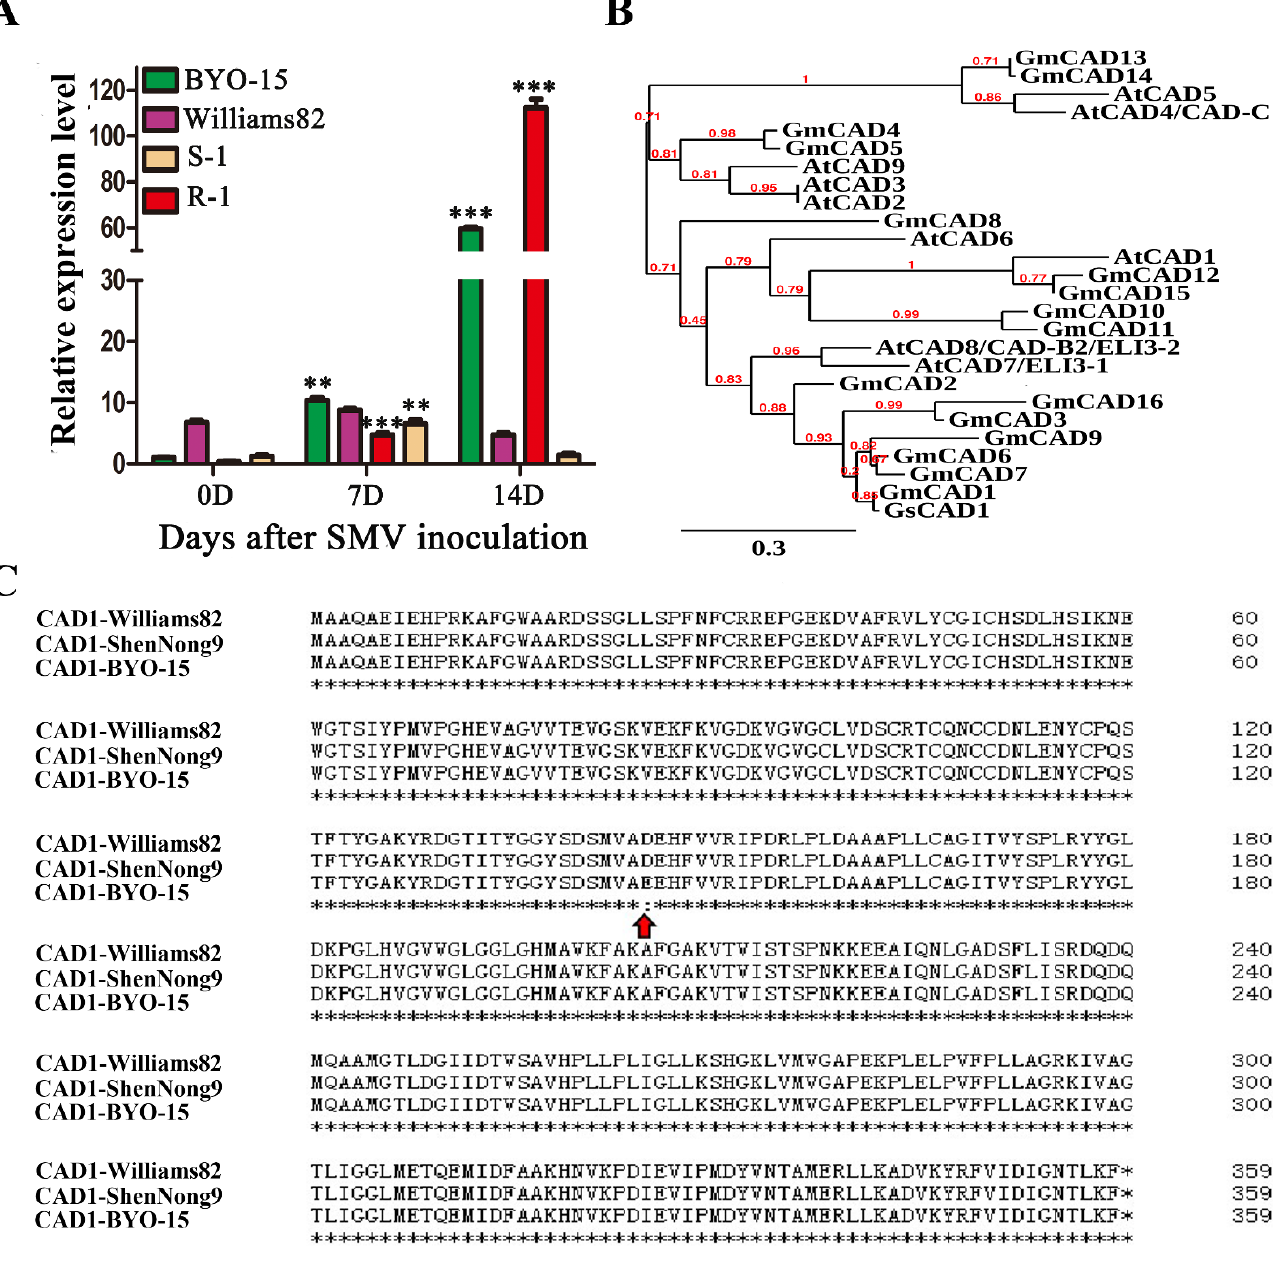
Figure 1. Mining anti-SMV gene of GsCAD1 . ( A ) Expression changes of CAD1 gene in highly re- sistant wild soybeans and susceptible cultivar and their hybrid descendants in S3 generation includ- ing one resistant plant (R-1) and one susceptible plant (S-1) before and after SMV inoculation based on qRT-PCR ( n = 3), and the asterisks represent significant differences of expression between wild and cultivar soybeans (Student’s t -test, **, p < 0.01; ***, p < 0.001). ( B ) Neighbor-join (NJ) phylogeny tree of 16 CAD members in soybean from the reference genome of Williams 82. The percentage represents the supported ratio based on 100 bootstraps. ( C ) Amino acid alignments of CAD1 among Willianms82, shennong9 and BYO-15. The red arrow represents the missense mutation site on the 145 amino acids (E145D), between the wild soybean (BYO-15) and the SMV-susceptible soybean cultivars (Williams 82 and Shennong 9).